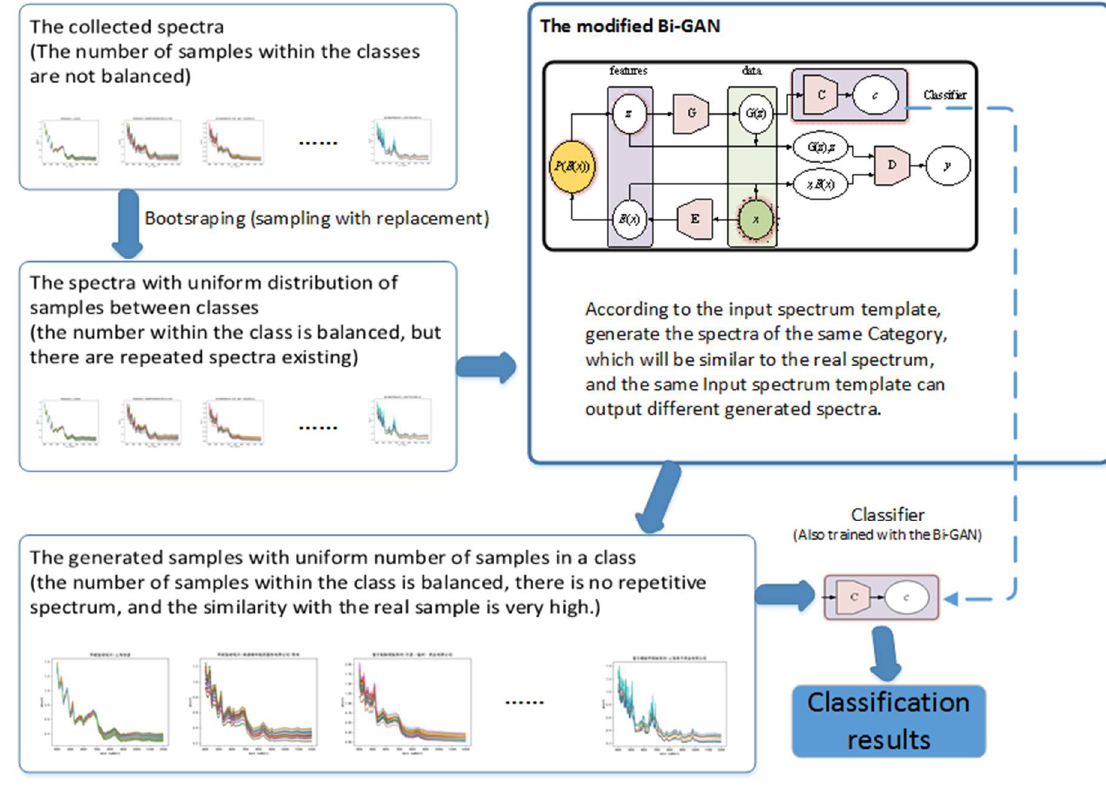
Figure 6. The main process of the proposed method.